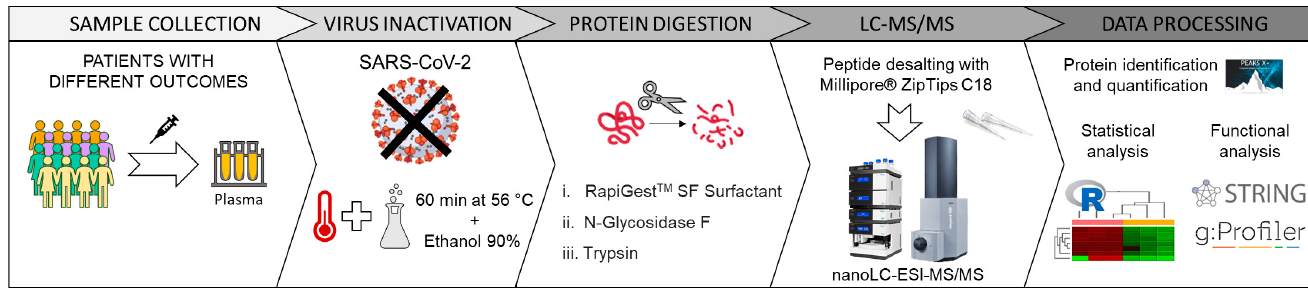
Figure 6. Experimental design. Brief illustration of the workflow, from the collection of the samples from COVID-19 patients with different outcomes to the statistical and functional analysis. After the collection, samples undergo an inactivation process of SARS-CoV-2 virus, then, proteins are deglycosylated and enzymatically digested, the peptide mixture is analysed by LC-MS/MS and data are finally processed by specific software.